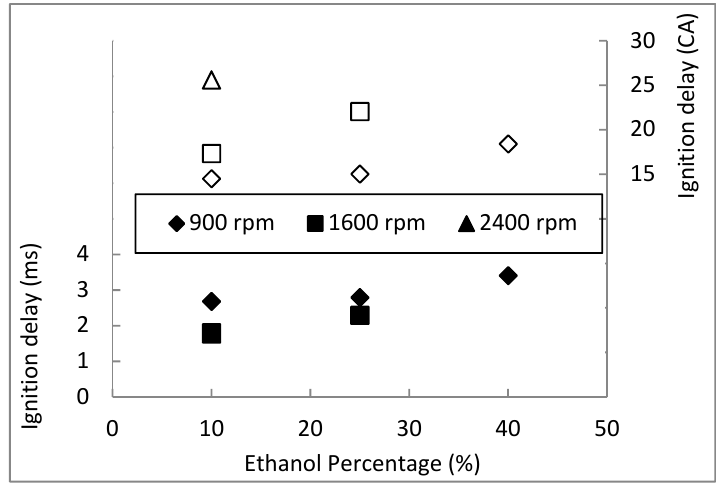
Figure 5. Ignition delay of the combustible blends with different ethanol percentages.